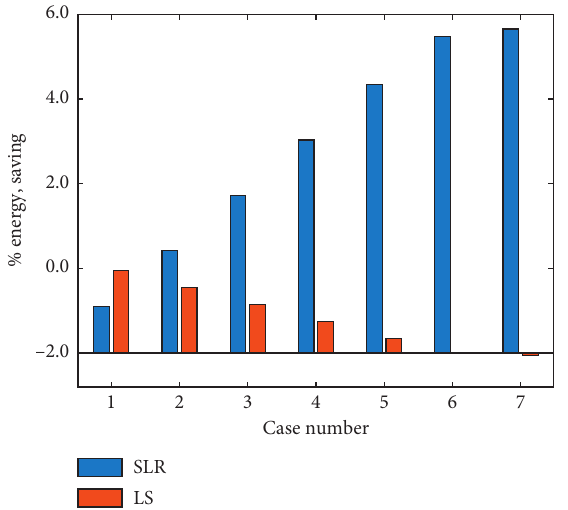
Figure 9: SLR and LS on energy-saving.